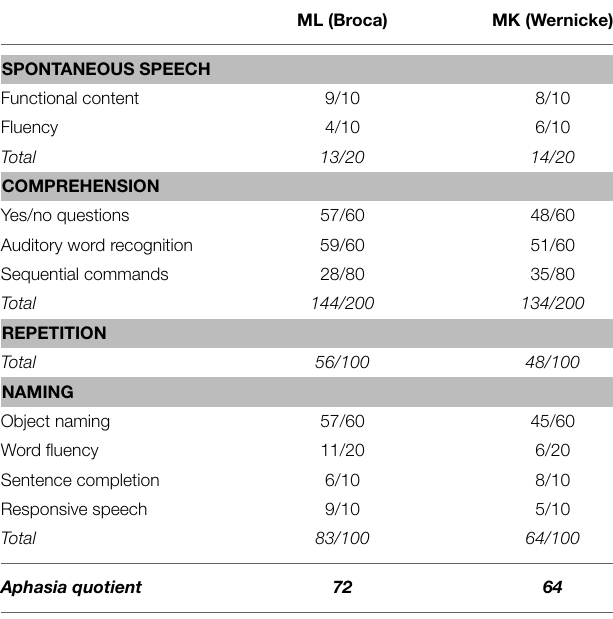
TABLE 1 | Subscores—Western Aphasia